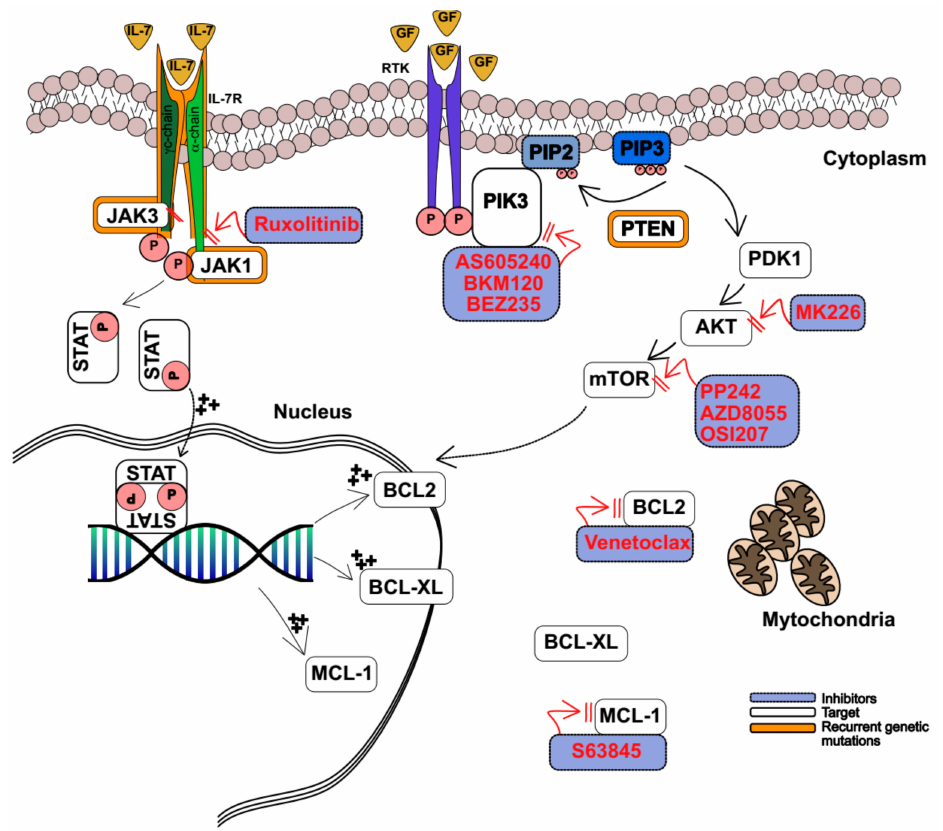
Figure 2. Kinase signalling pathway. In normal cells IL7 binds to its receptor IL7R. This interaction induces phosphorylation of Janus kinase 1 (JAK1) and JAK3 and activation of signal transducer and activation of transcription (STAT5) proteins. Phosphorylated STAT5, dimerizes and translocates into the nucleus and regulates the transcription of several genes, including the antiapoptotic BCL-2, BCL-XL, and MCL1. Growth factors bind to receptor tyrosine kinase (RTK), which trigger the activation of phosphatidylinositol-3 kinase (PI3K). PI3K phosphorylates phosphatidylinositol-3,4 bisphosphate (PIP2) into phosphatidylinositol-3,4, 5 trisphosphate (PIP3). PIP3 recruits the phosphoinositide-dependent kinase-1 (PDK-1) and the serine / threonine kinase (AKT) to the cell membrane, where they activate downstream e ff ectors including the mammalian target of rapamycin (mTOR). Among its activities, mTOR induces the expression of the antiapoptotic protein MCL1. Phosphatase and tensin homolog (PTEN) are responsible for PIP3 dephosphorilation. In leukemic cells activating mutations in the IL7R-JAK-STAT pathway mediate steroid resistance, thus JAK1 / 2 inhibitors (ruxolitinib) could reverse glucocorticoid resistance. Activating mutations of PI3K and AKT are rare, while loss of PTEN is frequent in T-ALL. This leads to loss of negative control and persistent “on” status of AKT-mTOR signaling. Selective PI3K inhibitor (AS605240), dual PI3K-mTOR inhibitor (BEZ235), panPI3K inhibitor (BKM12), AKT inhibitor (MK2206), and mTOR inhibitors (PP242, AZD8055 and OSI027) act at di ff erent stages of this signaling pathway and may restore apoptosis in T-ALL cells. Hyperexpression ( +++ ) of the antiapoptotic proteins BCL2 and MCL1 is counteracted by venetoclax or Mcl-1 inhibitors S63845, respectively. Black arrows show signal transduction. Red arrows show